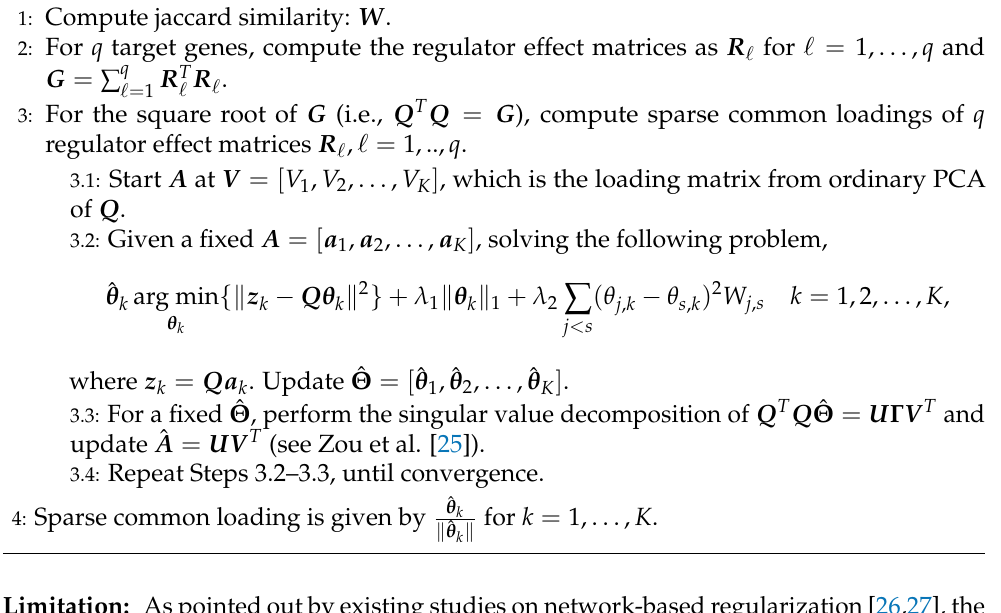
Algorithm 1 NetSCCA: Network constrained sparse common component